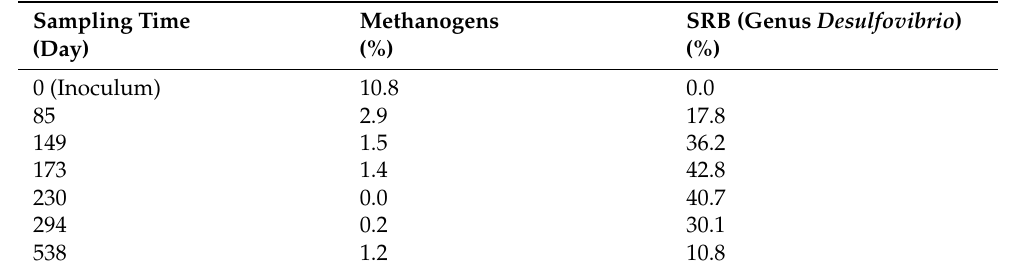
Table 3. Relative abundances (%) of methanogens and sulfate reducers (genus Desulfovibrio ) on the different samples throughout the operation of the UASB reactor.